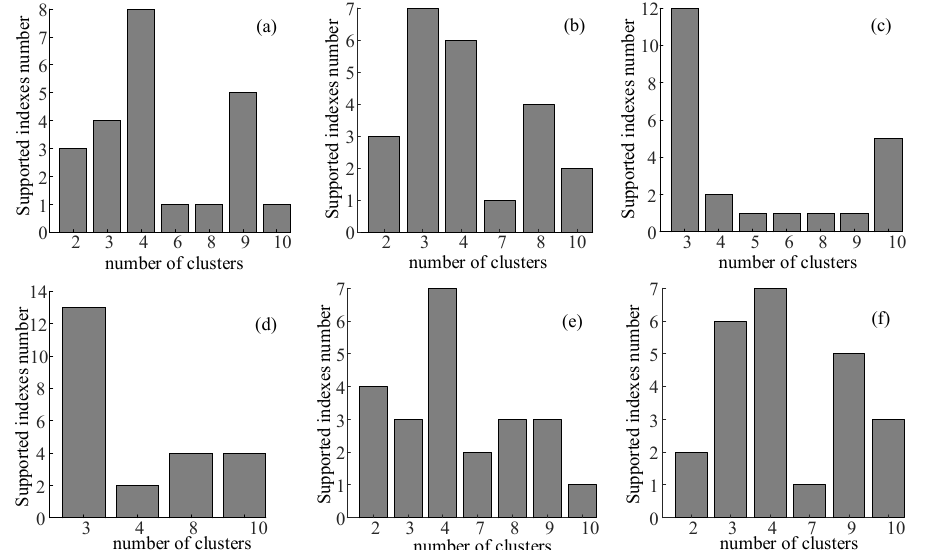
Figure 3. Optimal numbers of members’ clusters in the management depression community (MDC) regarding ( a ) emotion, ( b ) emotional support, and ( c ) informational support; optimal numbers of members’ clusters in the lacking-management depression community (LDC) regarding ( d ) emotion, ( e ) emotional support, and ( f ) informational support. Table 3. Clustering results and proportion of groups in each type.